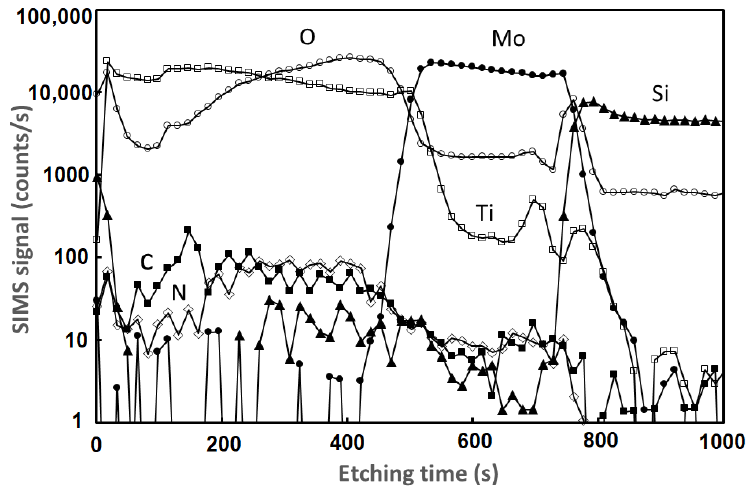
Figure 3. SIMS depth profiles of as-deposited Mo–Ti bilayer films .